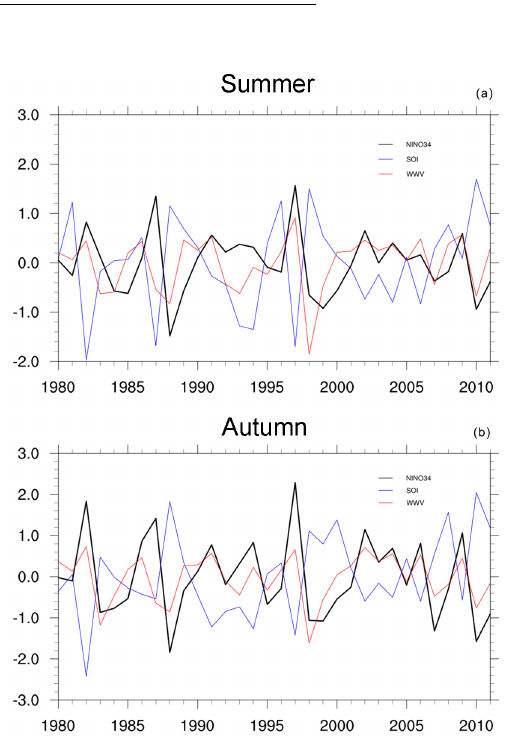
Figure 1. Niño3.4, SOI and WWV indexes in summer (Fig. 1a) and Niño3.4, SOI and WWV indexes in autumn (Fig.